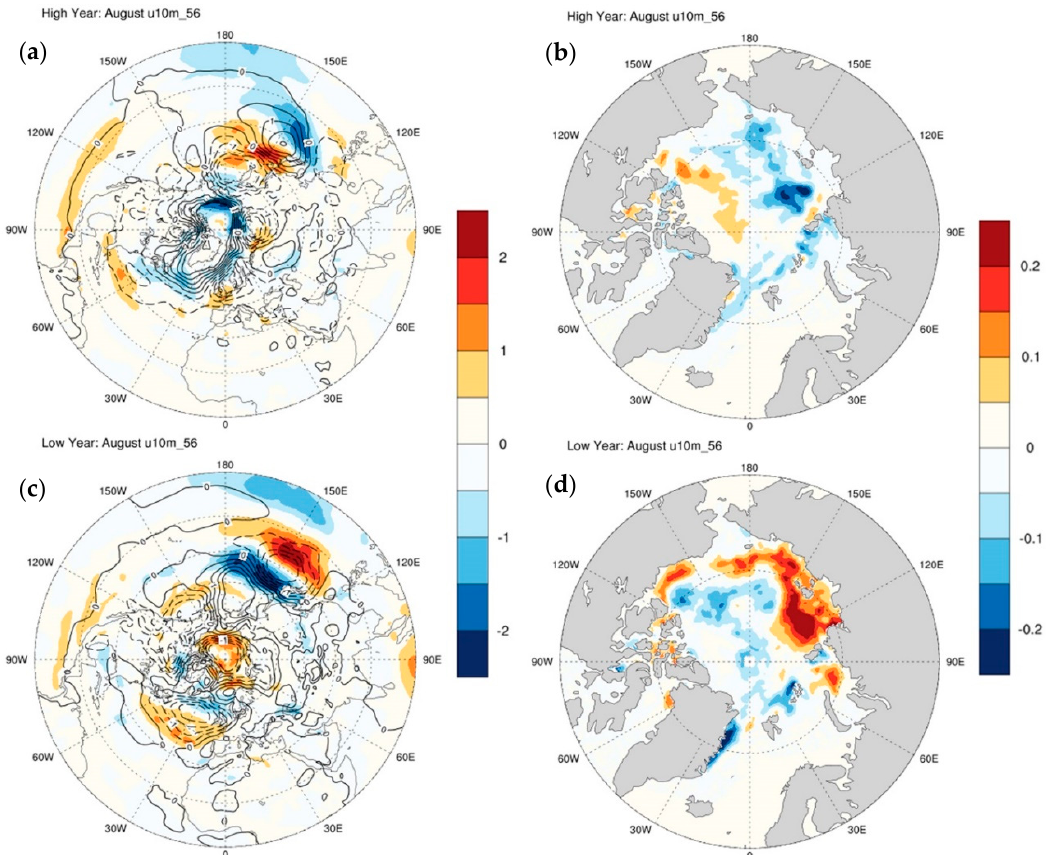
Figure 5. Composite anomalies of ( a , c ) August zonal component of wind at 10 m (shade interval: 0.5 m/s) and sea-level pressure (contour interval: 0.5 hPa); and ( b , d ) September SIC (shade interval: 0.05). The top (bottom) two plots correspond to the years when August u10m_56 (39.0 ◦ N, 150.8 ◦ E) is one standard deviation larger than its climatology mean in the positive (negative) phase.